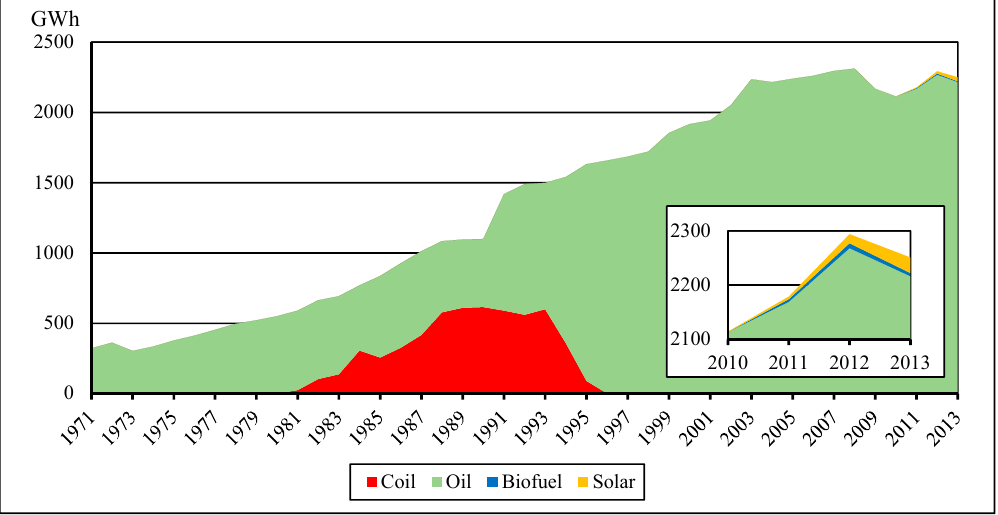
Figure 4. Electricity generation by fuel in Malta (1971–2013) [19]. Peat and oil shale are aggregated with coal.